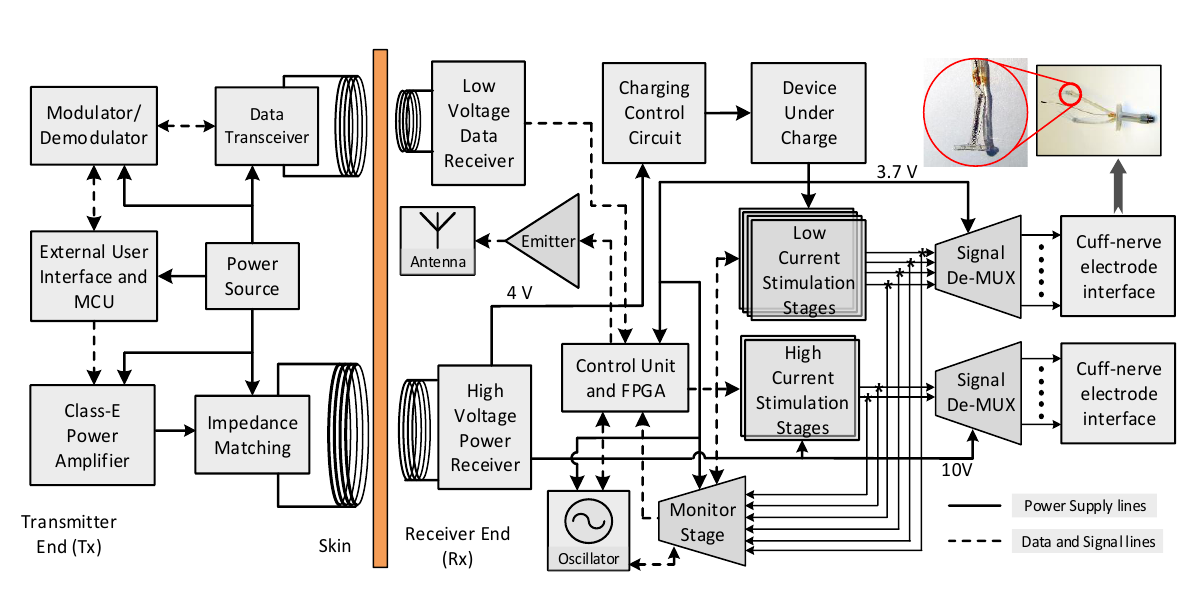
Block diagram of the wireless power and data transfer chain for the